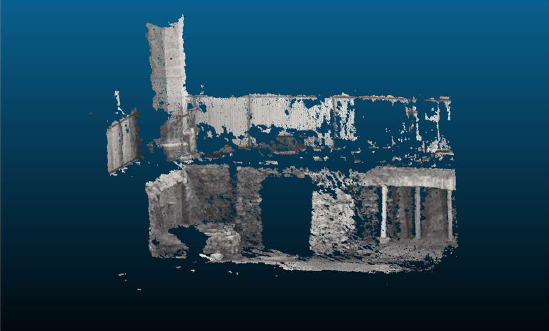
Figure 8 . Sparse point cloud obtained with the manual selection of feature points workflow.